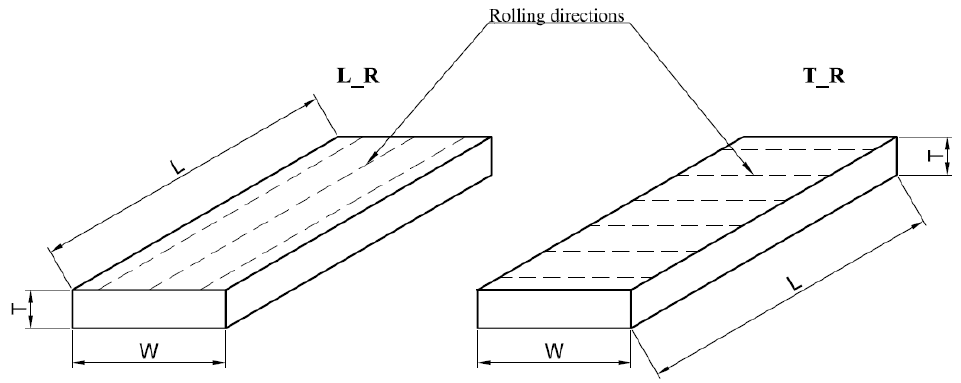
Figure 1. Rolling directions for tested aluminium alloy samples. L_R—longitudinal rolling direction; T_R—transverse rolling direction; L—length of the sample (mm); W—width of the sample (mm); T—thickness of the sample (mm).